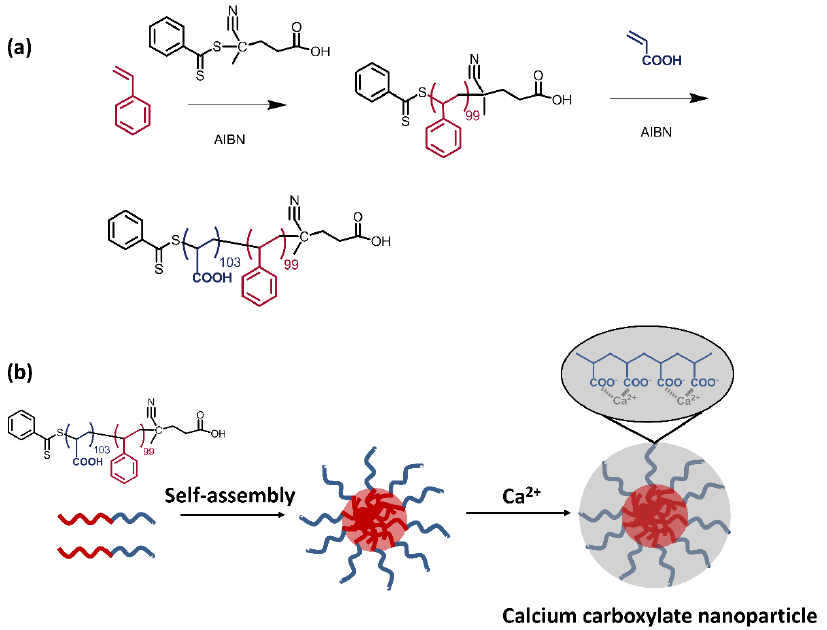
Figure 1. ( a ) Synthetic routine of targeted PS- b -PAA and ( b ) schematic of amphiphilic micelle structure from self-assembly in water solution of cement paste.